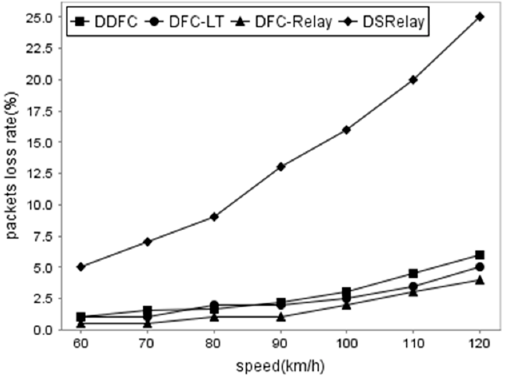
Figure 5. Comparison of packet loss rates using the DDFC, DFC-LT, DFC-Relay, and DSRelay methods.